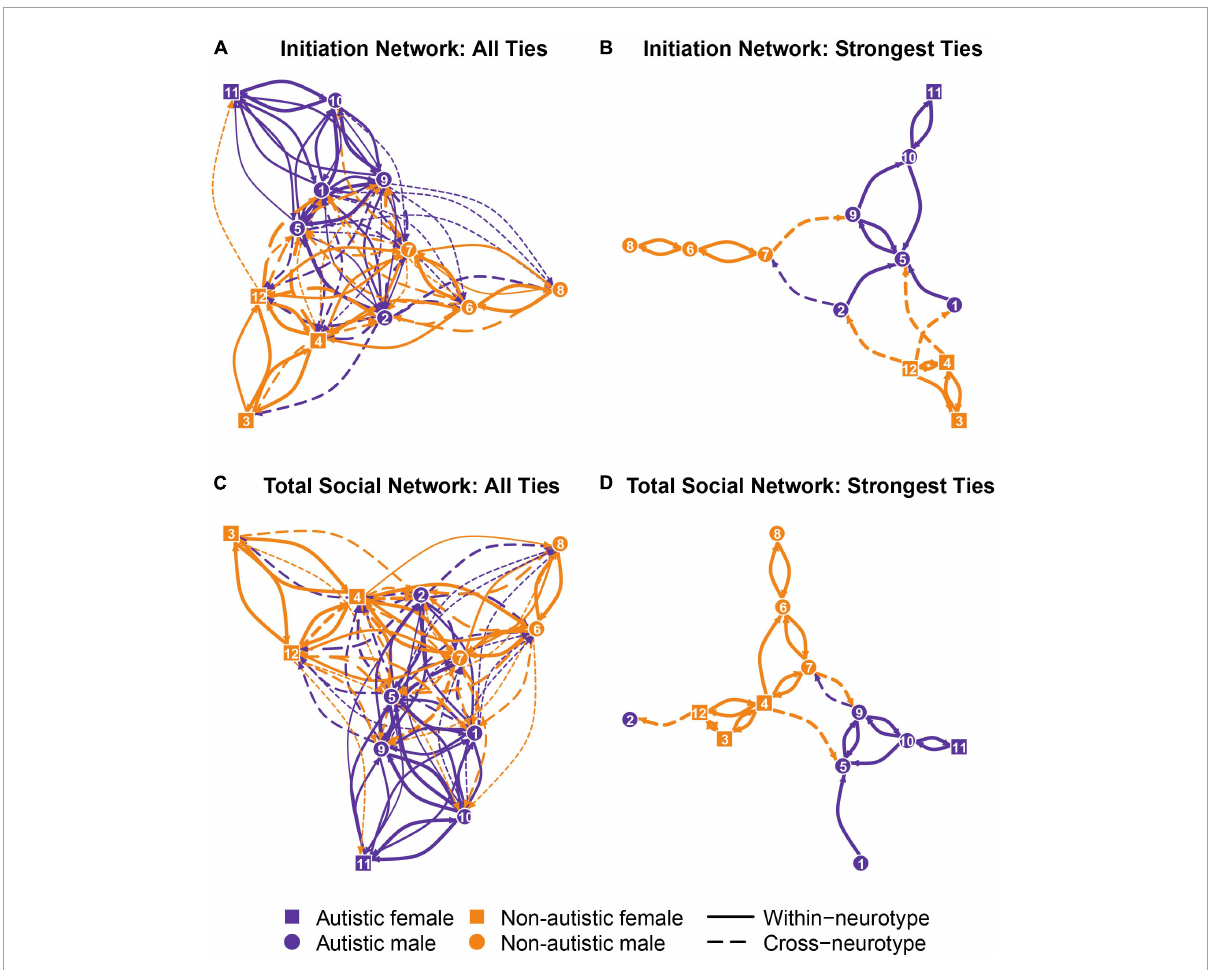
FIGURE1 Mean social networks across observations. Each node represents a student in the club, and each edge between a pair of nodes represents the peer relationship between the dyad. Arrows represent the direction of the edges, pointing from the sender to the receiver of social interactions. The width of an edge indicates the strength of the social tie (the thicker the edge, the stronger the tie). (A) The network of social initiations among youth. (B) A subnetwork of panel A with only the strongest social ties. (C) The network of all social interactions (initiations and responses) among youth. (D) A subnetwork of panel C with only the strongest ties.